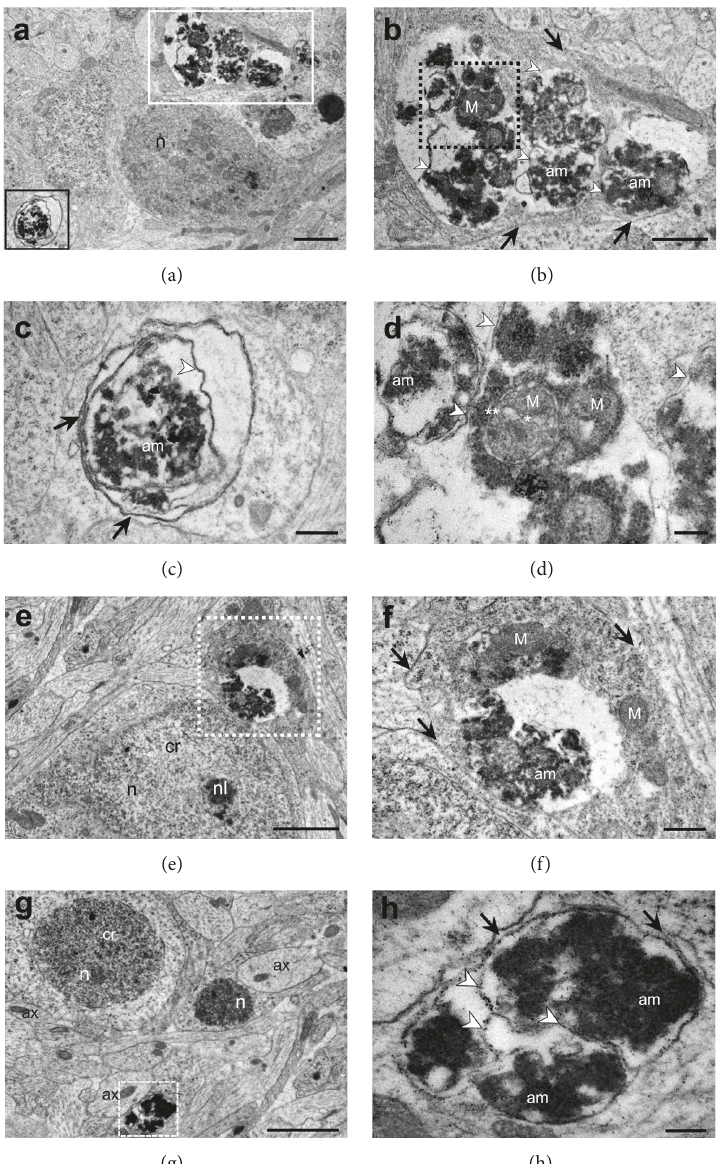
Figure 5: Autophagic vacuoles in spinal cord of MeHg-treated embryos . Cells in mantle layer show autophagic vacuoles in different stages of autolysis(a–h).Plasmamembranesdelimitthecells(blackarrow)andinnermembranesdelimitcompartmentssimilartoautophagicvacuoles (whitearrowhead). Mitochondria(M)with IMM ( ∗ ) and EMM ( ∗∗ ) still preserved,inside early autophagicvacuole(a-b,d). Laterautophagic vacuoles with amorphous (am), homogeneous, and more electron-dense content (a, c, g, h). (a) Spinal cord cells in lower magnification. (b) Magnification of the cell inside of the white box in (a). (c) Magnification of the cell inside the black box in (a). (d) Magnification of the autophagic vacuoles of the black dotted box in (b). (e) Spinal cord mantle layer cells. In the white dotted box, there is a cell in autophagy. (f) Magnification of the cell in the death process inside the white dotted box in (e). (g) Cell with amorphous and more electron dense cytoplasm in white dashed box. (h) Magnification of the highlighted cell in (g). Axon (ax) of neuronal cell in transverse section, chromatin (cr), nucleus (N), and nucleolus (nl). Scale bars: (a, e) 2 𝜇 m; (b) 1.0 𝜇 m; (c) 0.5 𝜇 m; (d,f) 0.2 𝜇